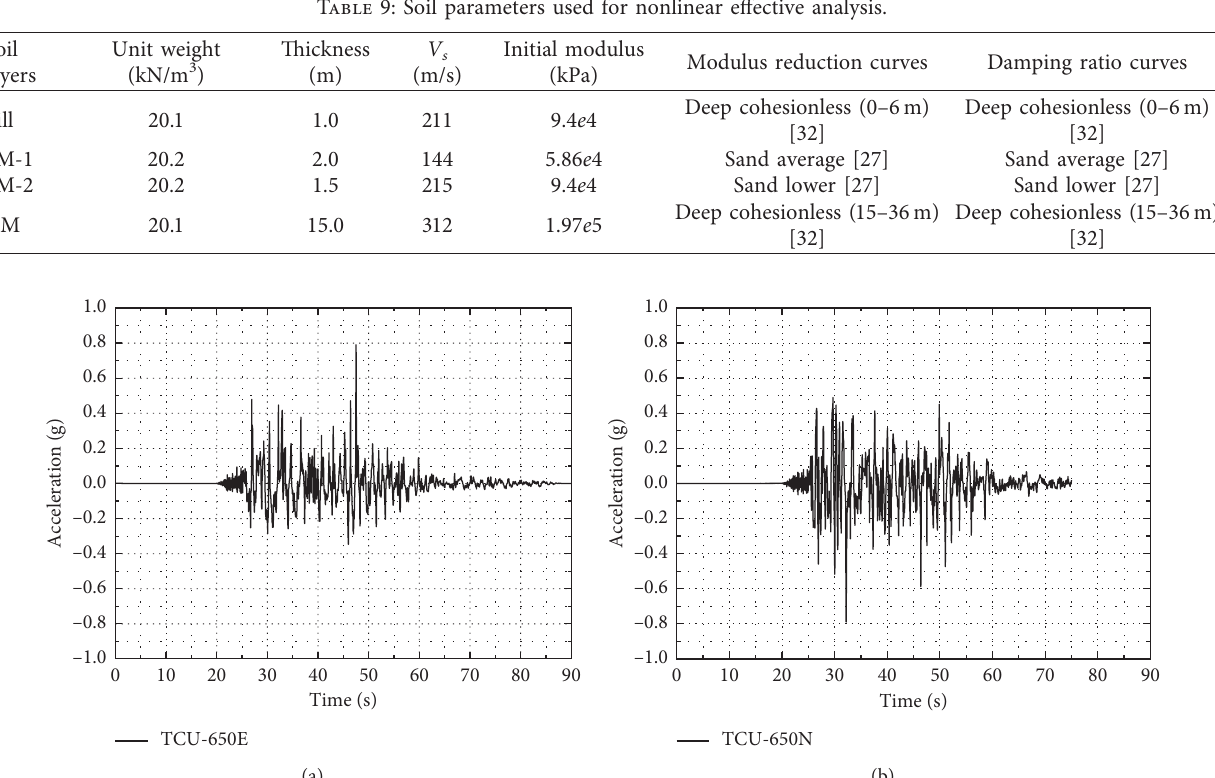
Figure 16: Input motions at the base of the soil profile. (a) TCU-650E and (b) TCU-650N.